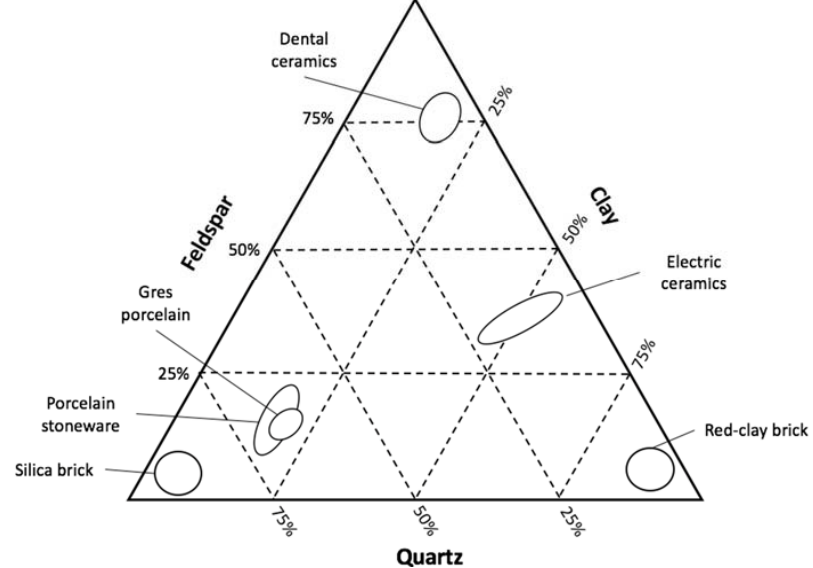
Figure 1. Graph of the main compositions of relevant types of ceramic materials built with data from Richerson et al. [8].